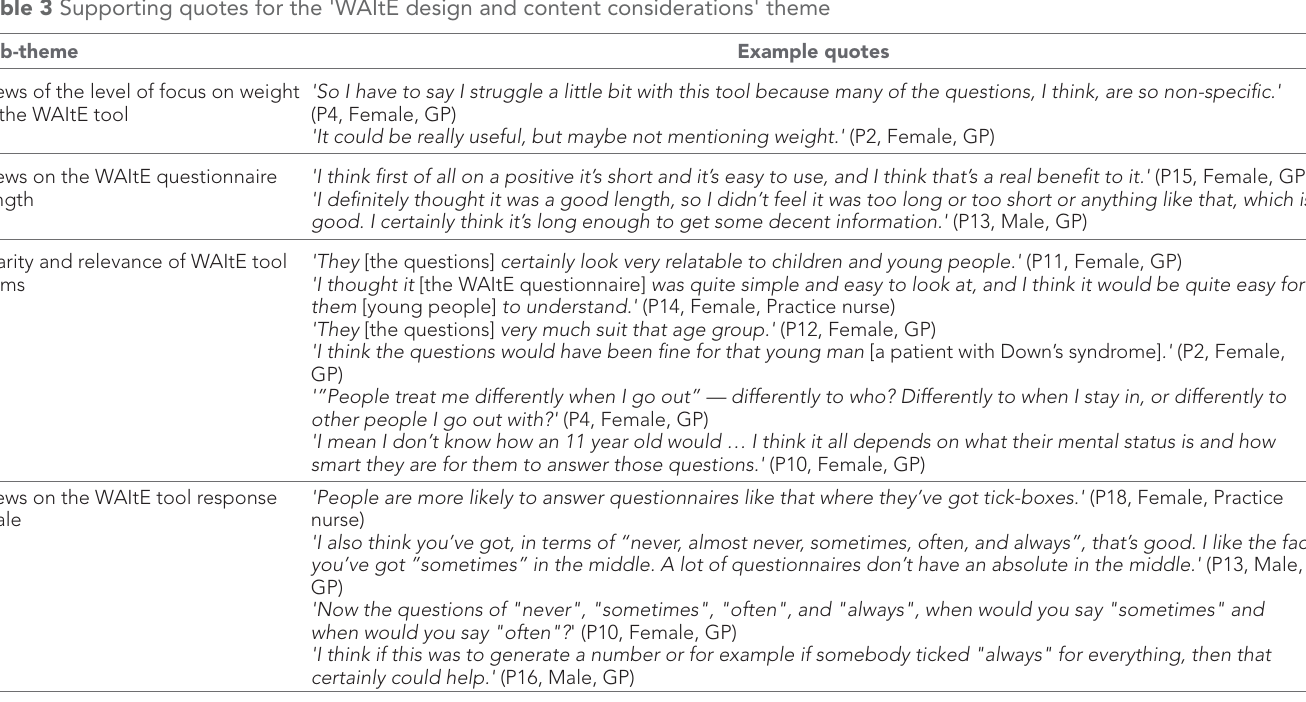
Table 3 Supporting quotes for the 'WAItE design and content considerations' theme Sub- theme Example